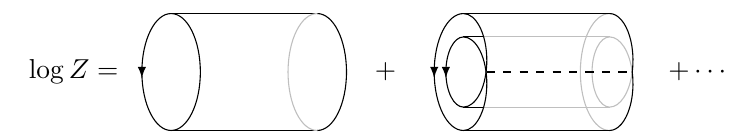
Figure 11 . In the free theory, the relevant diagrams are cylinders that wind around the direction corresponding to the entanglement time. The open ends of the cylinder are wrapped around the two